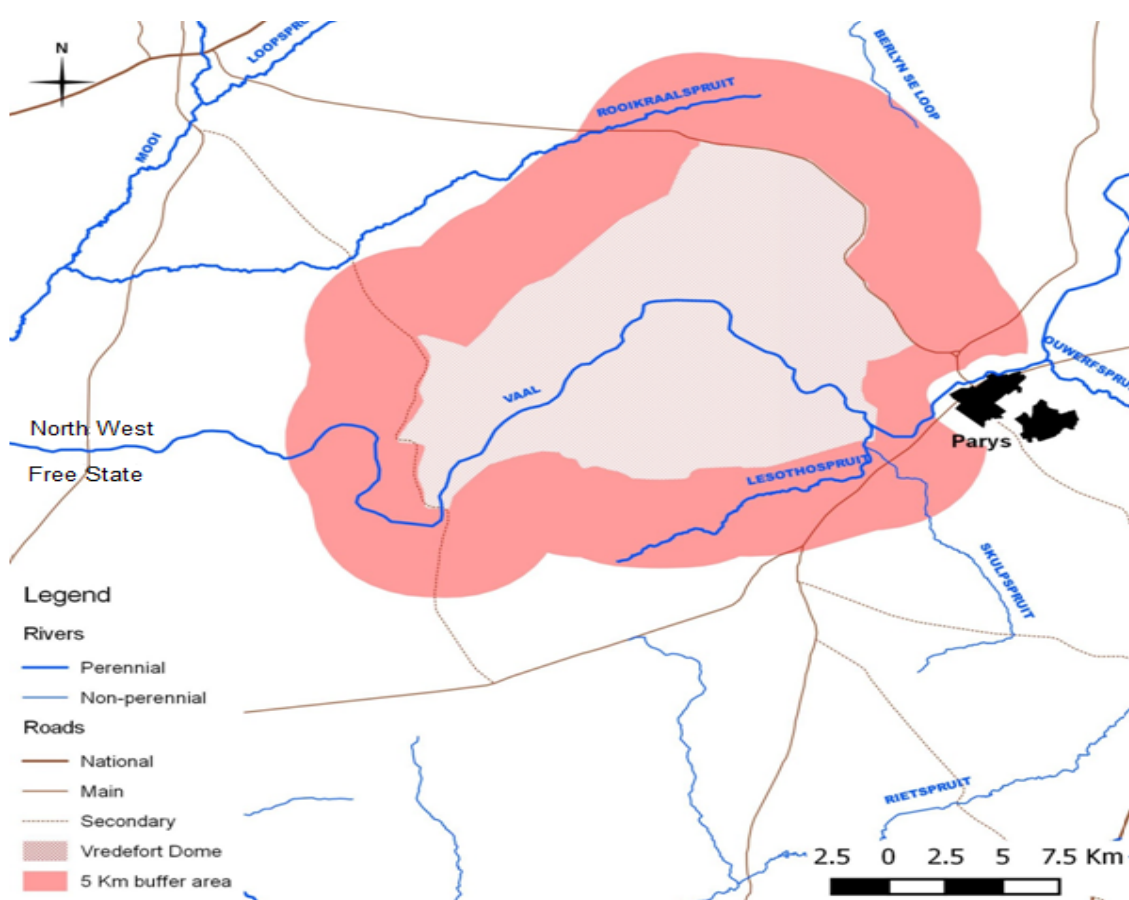
FIGURE 1: The location of Parys and the edge of the Vredefort Dome impact crater along the Vaal River (Lerm,